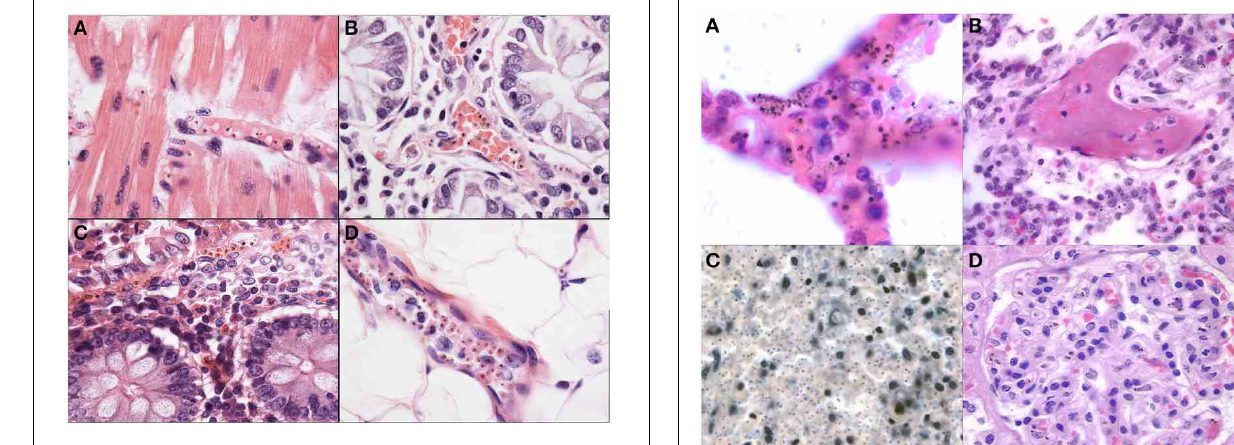
FIGURE 6 | Representative images of pathology outside of the brain are shown. The heart (A) was a common site of sequestration and parasites could consistently be found in CM patients (1000X, H&E). The small bowel (B) , including jejunum and ileum, as well as the stomach and colon (C) were common sites for sequestration in all patients, regardless of diagnosis, although the most intense sequestration in the gastrointestinal tract was in CM patients (400X, H&E). The subcutaneous adipose layer of the skin (D) was a common site of dense sequestration but, unlike the gastrointestinal tract, was only seen in cases with CM.